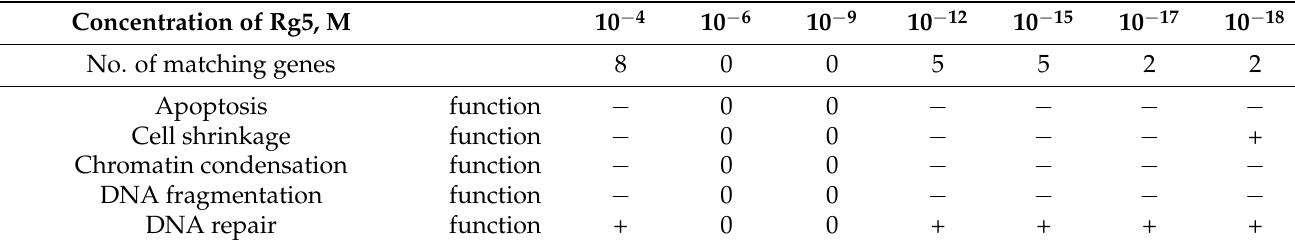
Table 6. The number of genes matching senescence signaling pathway and predicted effects of Rg5 in cellular processes associated with apoptosis 1 .